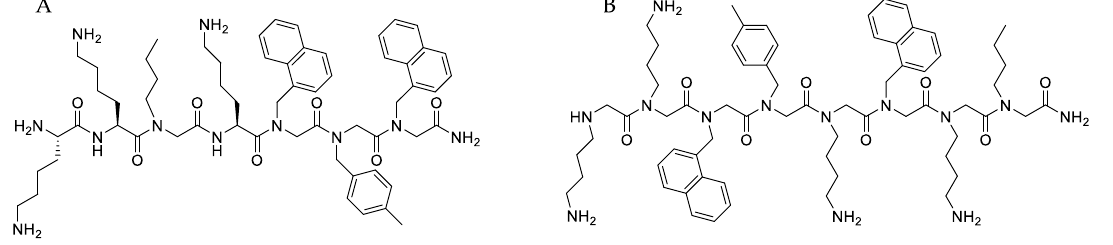
Figure 1. Structure of B1 ( A ) and D2 ( B ) both isolated as trifluoacetic acid